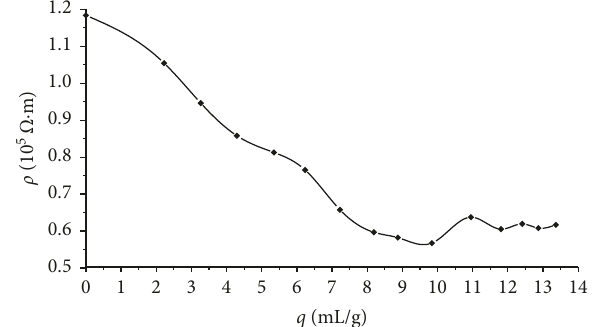
Figure 6: Resistivity vs. gas content during isovolumetric